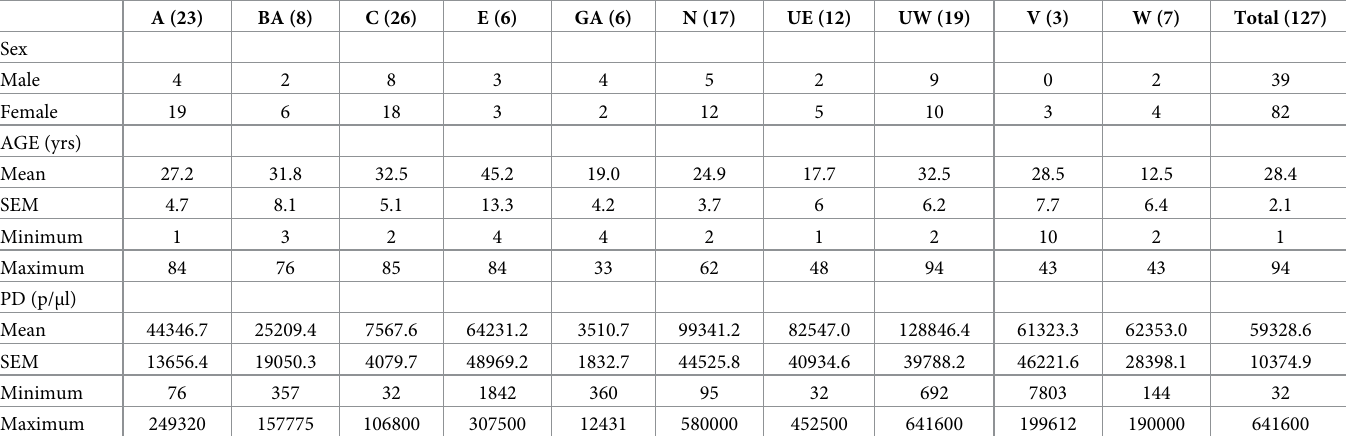
Table 1. Demographic characteristics of the 127 study participant with false negative RDT results by Region.